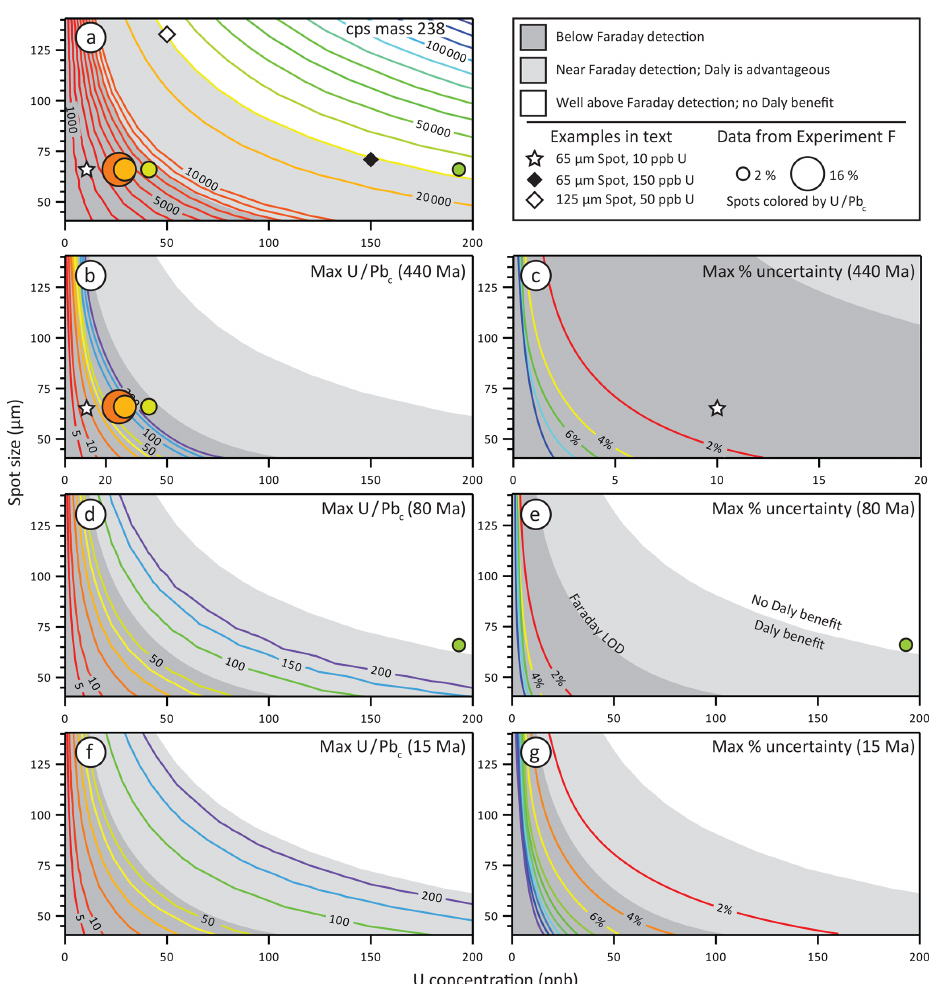
Figure 6. Panel (a) shows the count rate expected with the Nu P3D given for a given spot size at a laser energy of ∼ 1Jcm − 2 and 10Hz. Panels (b) , (d) , (f) show the maximum U / Pb c that can be achieved with the given U concentration and spot size (colored contours); the star symbol in (b) illustrates an example that a 65µm spot with 10ppb U can yield a U / Pb c no better than ∼ 13, otherwise 207 Pb will be below detection (i.e., < 30 cps; example explained in text). Colored circles indicate analyses of unknowns in Experiment F ( 238 U on the Faraday; Table 2; 65µm, average U parts per billion); color represents the maximum U / Pb c ratio – taken from Table 2 – and the size represents the final uncertainty. Note that the maximum U / Pb c correlates with U concentration. In all plots, the grey area (dark and light) represents the region in which measurement of 238 U on a Daly is advantageous to that on a Faraday; open and filled diamonds in (a) represent examples in text in which spots smaller or lower in U are favorably measured on the Daly detector. Dark grey region represents spot sizes and U concentrations too low for measurement on a Faraday detector. Panels (c) , (e) , and (g) show the best possible uncertainty (colored contours) at the given count rates and spot sizes for 100 analyses, all with the same U concentration but a uniform distribution of 238 U / 206 Pb ratios. Star symbol in (c) explained in